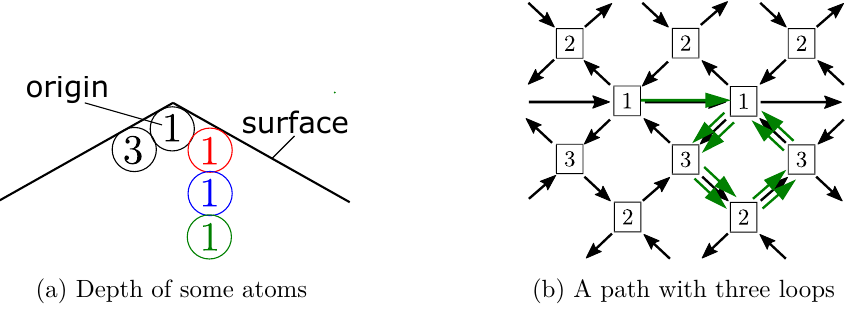
Figure 6. Depth of atoms in a 3d crystal and the number of loops in periodic quiver diagram. The colors in (a) corresponds to those of loops in figures 5 and 6(b).